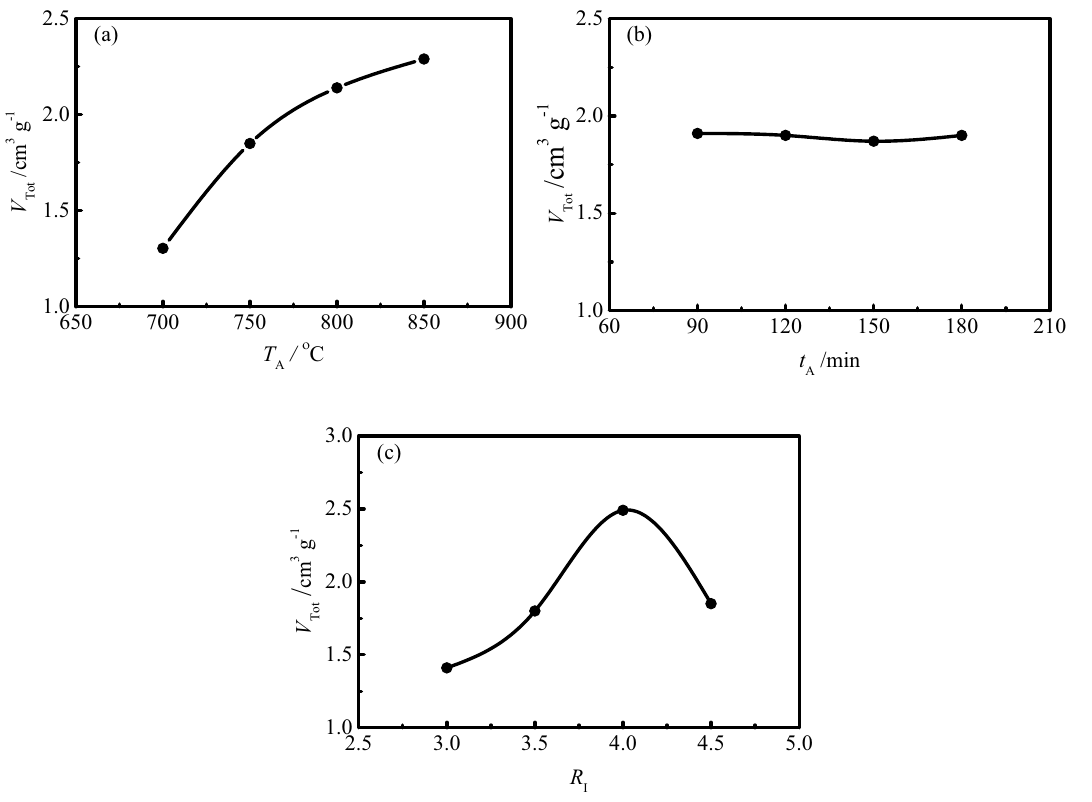
Figure 2. Effects of experimental factors on the total pore volume of SAC.